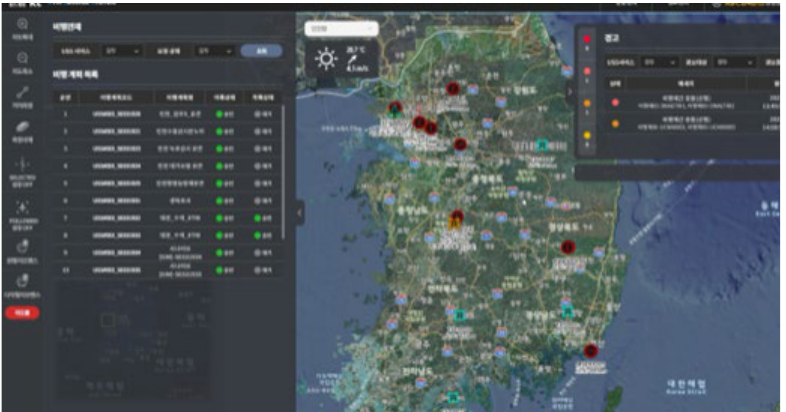
Figure 8. UTM system for USS.